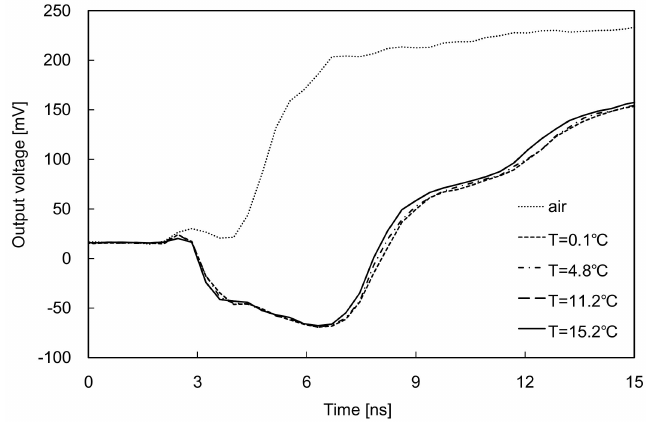
Figure 6. Effect of temperature on the dielectric constant estimated from using PTDR in distilled water. ‘T’ denotes the temperature of